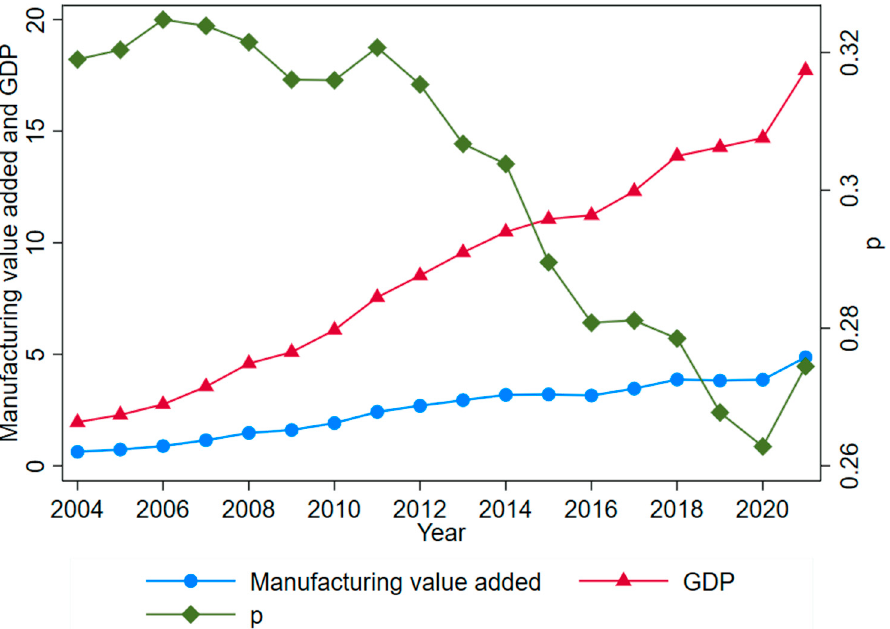
Figure 1. Trends of manufacturing value added and GDP in China. Notes: Data source for Figure 1 is the World Bank; unit: trillions of dollars (current dollar); p, the share of manufacturing value added in GDP.